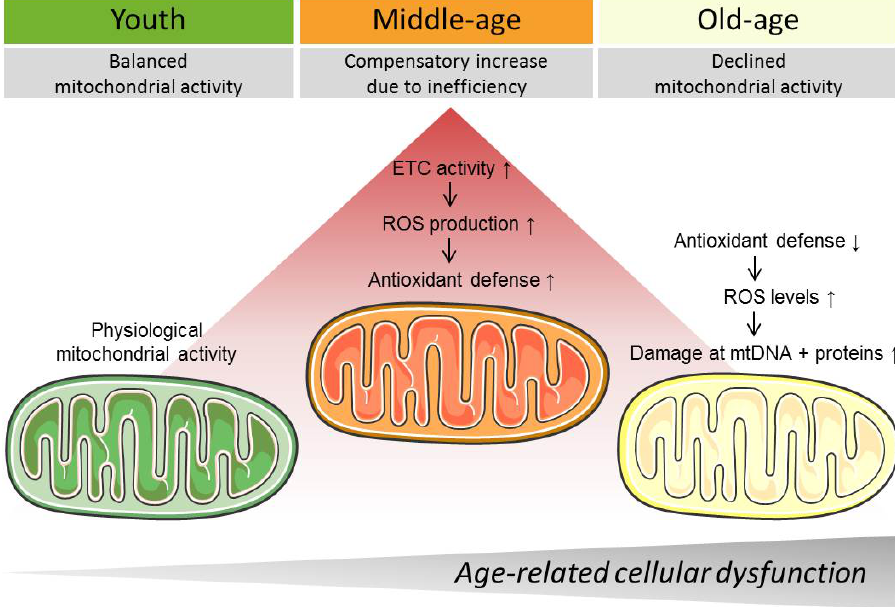
Figure 1. Biphasic alterations of mitochondrial function during aging. ETC: Electron transport chain, ROS: Reactive oxygen species, Mito: Mitochondrial, MtDNA: Mitochondrial desoxyribonucleic acid. Created using Servier Medical Art (Les Laboratoires Servier, Suresnes, France).